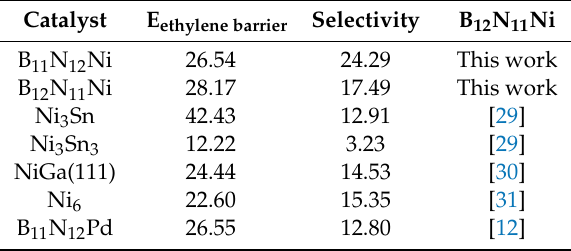
Table 3. Comparison of the energy barriers for the desorption energy of ethylene and the selectivity with di ff erent catalysts (energies in kcal / mol).